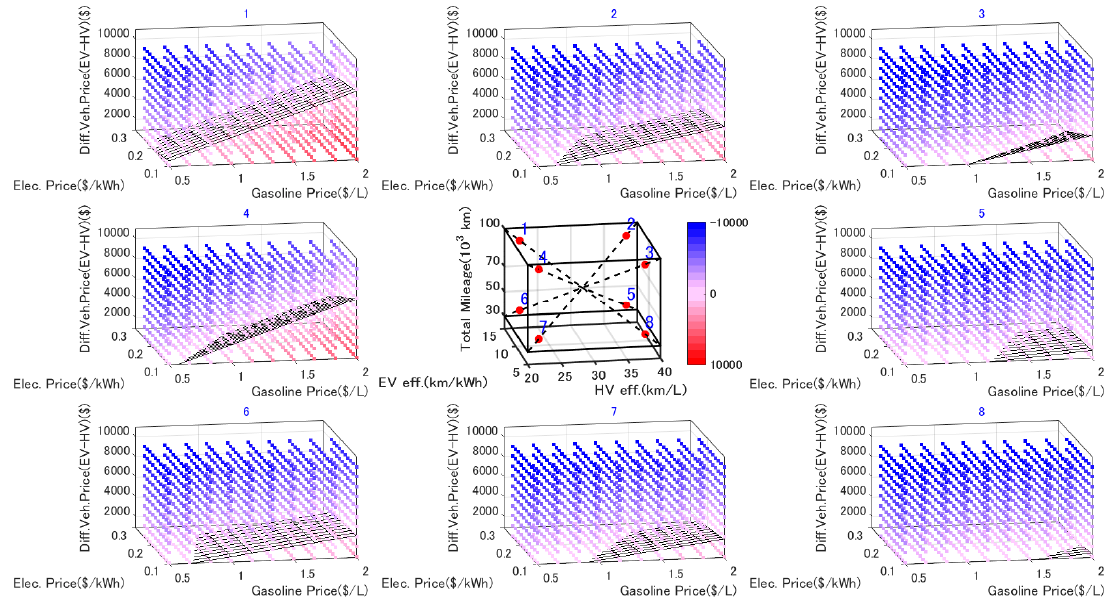
Figure 4. Six-dimensional diagram of comprehensive LCC comparison between HV and EV (regions colored in blue and red represent advantageous HV and EV, respectively).